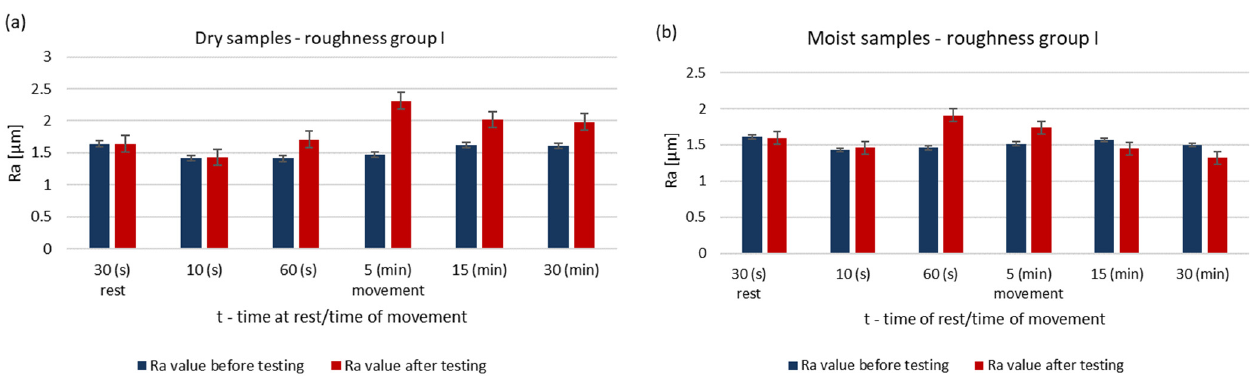
Figure 2. Changes in the value of the parameter Ra of steel pins for the roughness group I (Ra = 1.41–1.64 µ m): ( a ) tests performed in dry conditions, ( b ) tests performed with moist graphite rings.